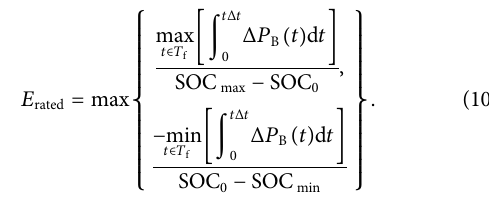
TABLE 5 Energy storage capacity con fi guration without considering